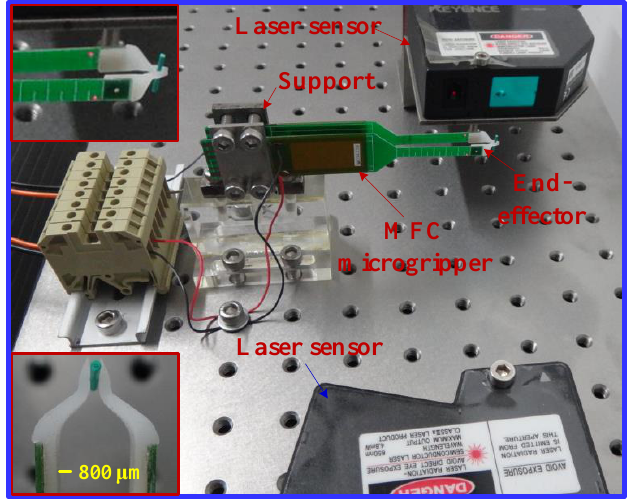
Figure 6. Photograph of the experimental setup.